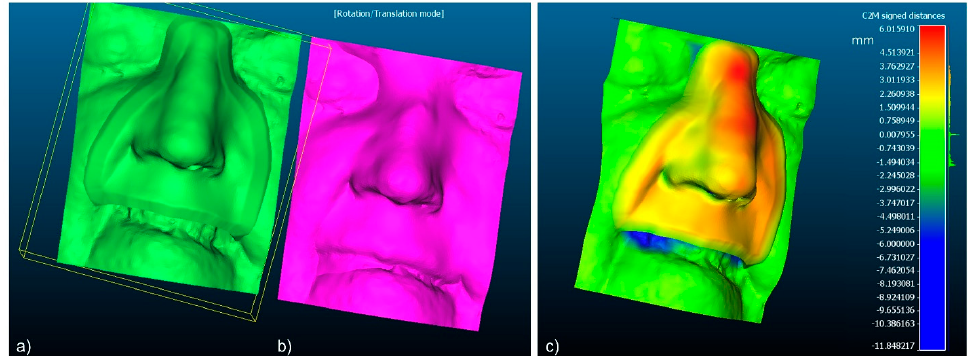
Figure 11. ( a ) STL after rehabilitation using the designed ephitesis (scan_POST); ( b ) STL of the combination of the patient and the daughter’s face scans (scan_REF); ( c ) the obtained distance mapping between scan POST and scan_REF.